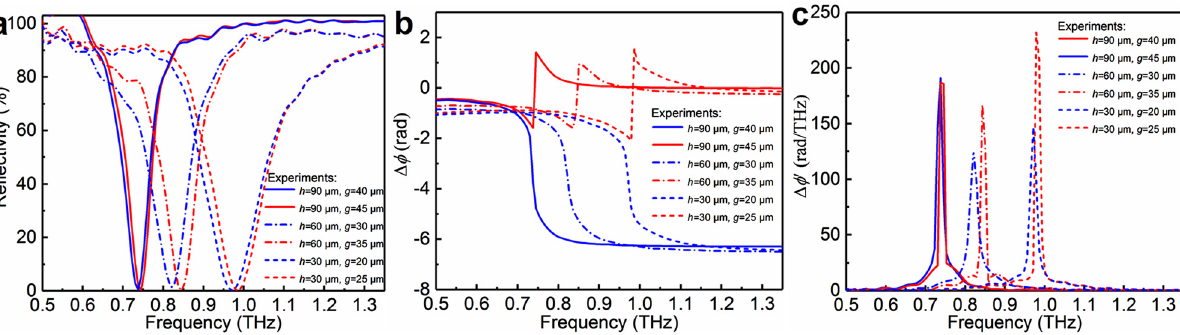
Figure 5: Experimental results of SPSs with different groove depths. (a) Reflectivity spectra, (b) Δ ϕ spectra, and (c) Δ ϕ spectra for three groove depths h = 30, 60 and 90 μ m.